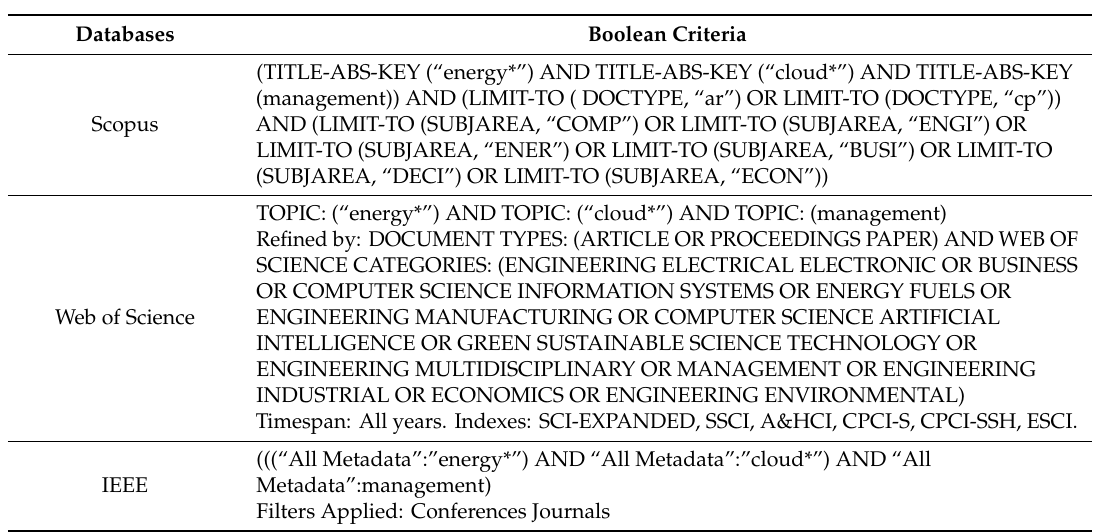
Table 2. Boolean